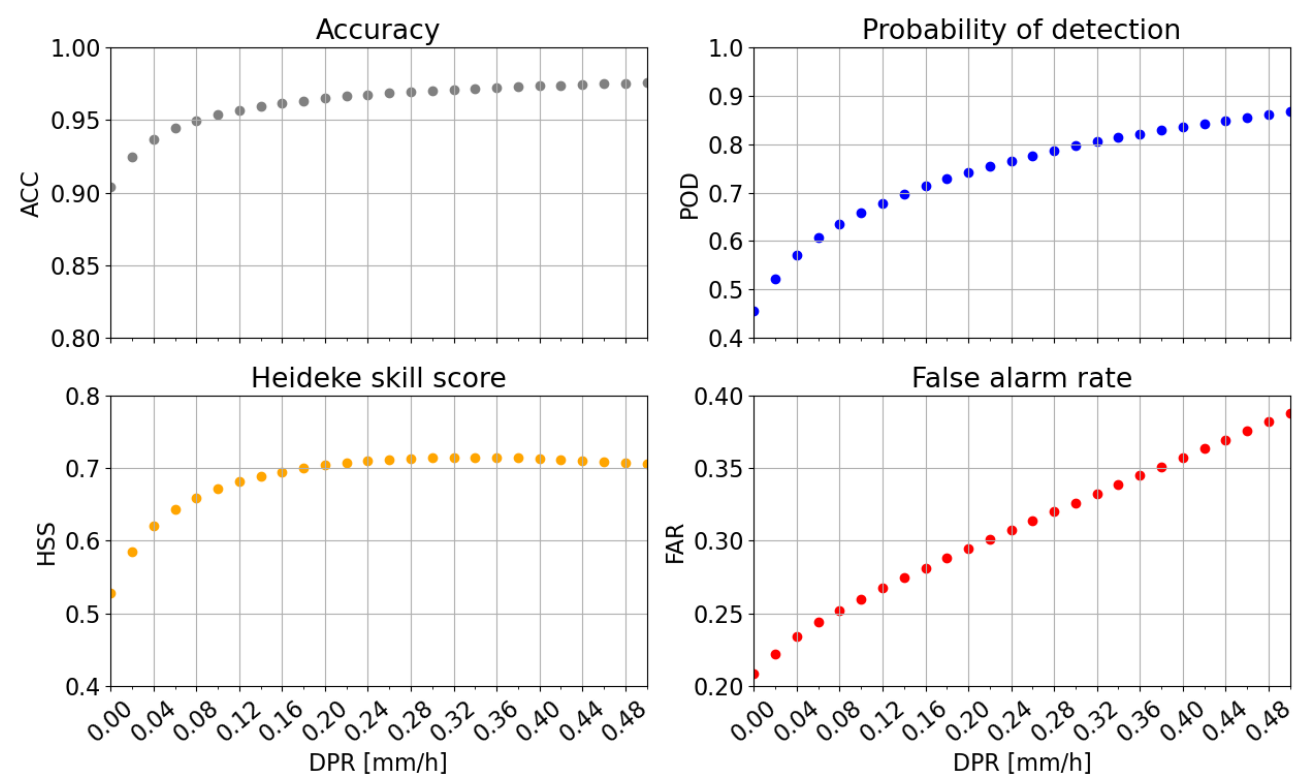
Figure 3. ACC, HSS, POD and FAR scores ( upper left , bottom left , upper right and bottom right panel respectively) at various detection thresholds δ . For δ > 0 the scores are evaluated over the reduced population of pixels with reference precipitation rate either equal to 0 mm/h or greater than δ